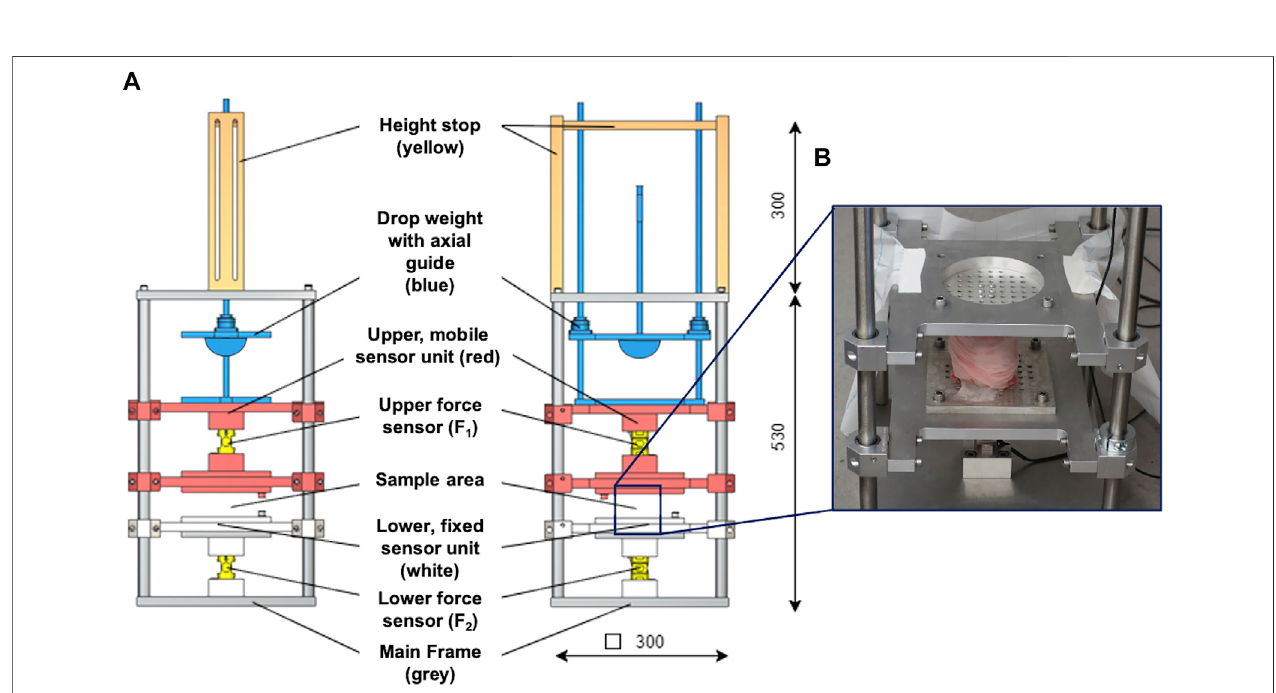
FIGURE2|(A) Technicaldrawing ofthedroptowersetupintheside(left)andfrontal(middle)view.Thesetupconsistedofaheightstop(ochre),whichwasdirectly connected to the axial guidance system ofthe drop weight. A hemisphere impactor (blue) was used to allow for pinpoint impact transmission. The upper, mobile sensor unit (red) is axially guided by eight axial ball bearings and incorporates the upper force sensor. It is further connected to an impact pad at its top end and to a sample holderatthelowerend.Thelower, fi xedsensorunit(white)isalsoaxiallyguidedbyfouraxialballbearingsandincorporatesthelowerforcesensor.Thelowerendof this sensor unit is directly connected to the main frame. (B) Example of an installed porcine knee joint at the sample area at the droptower setup.